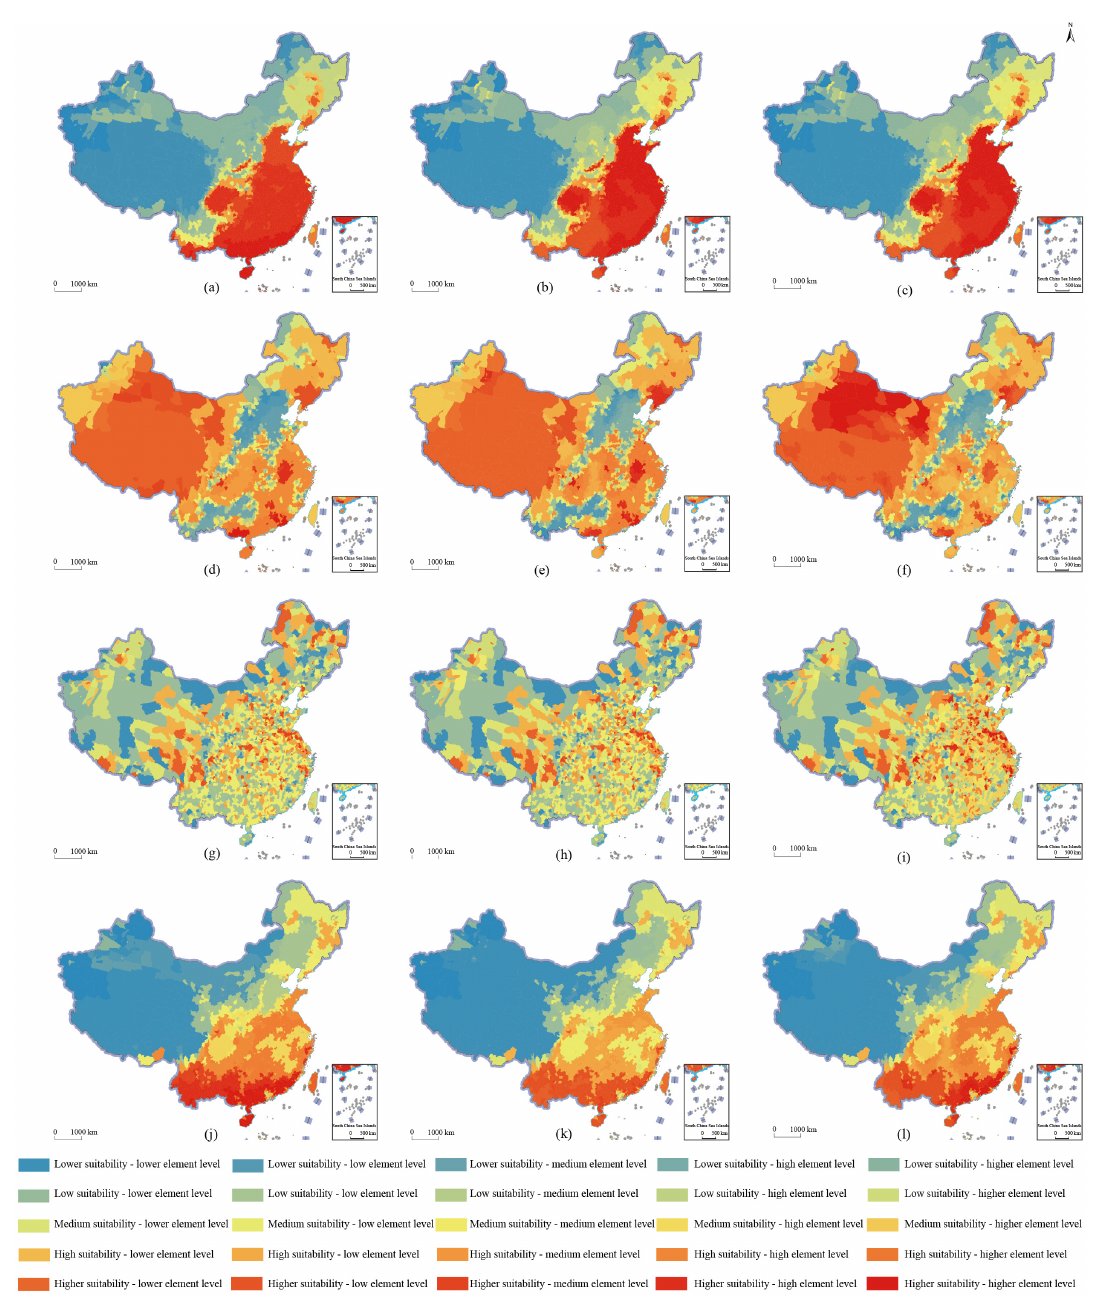
Figure 5. Spatial matching distribution of each first-level index and factor of agricultural production space suitability in China in 2018. ( a ) average annual temperature; ( b ) land-average secondary industry added value; ( c ) population density; ( d ) average annual temperature; ( e ) land-average secondary industry added value; ( f ) water-heat imbalance index; ( g ) population density; ( h ) night light index; ( i ) land-average secondary industry added value; ( j ) average annual temperature; ( k ) population density; ( l ) land-average secondary industry added value.